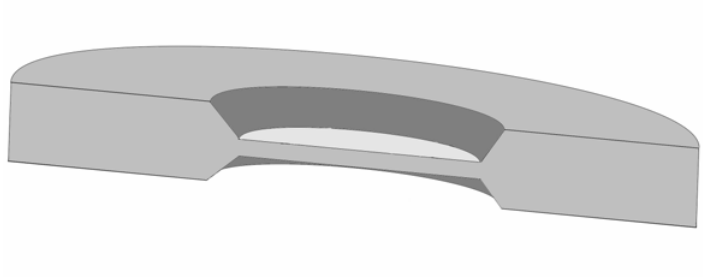
Figure 2. Cross section of an HFF quartz wafer realised with the Inverted Mesa